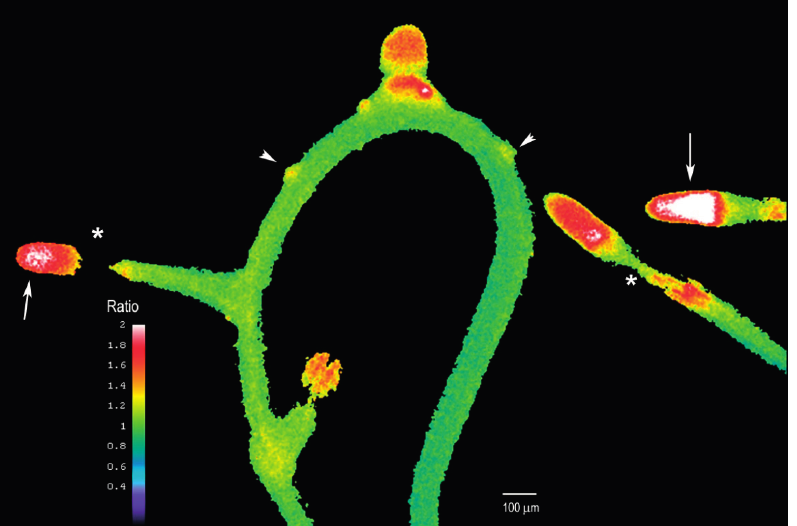
Figure 7. Arabidopsis roots exhibit increased intracellular H 2 O 2 levels after several days of exposure to Al. After 5 days of Al treatment, roots responded with an increase in lateral root formation. The newly formed lateral roots were shorter than those of control plants of the same age and had higher H 2 O 2 levels in the tip regions. However, the elongation zone remained and exhibited reduced H 2 O 2 levels. Arrows indicate the tip of the root where the division region is located, asterisks the elongation zone, and arrowheads the small lateral root